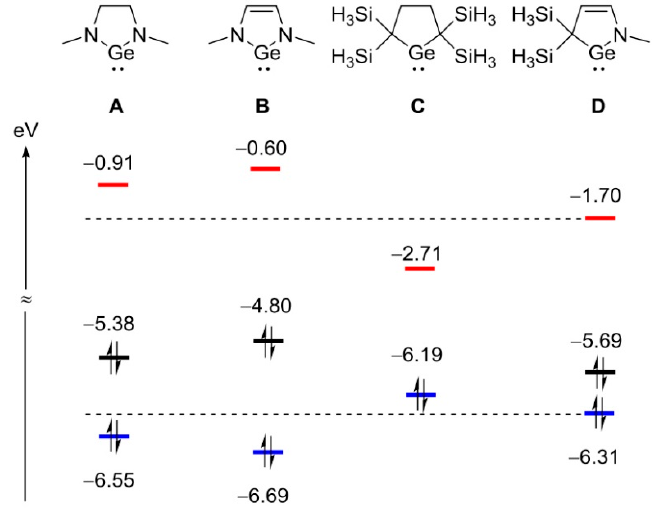
Figure 2. Energy (eV) of frontier orbitals of N -heterocyclic germylenes A , B , cyclic dialkylgermylene C and (alkyl)(amino)germylene D , calculated at the B3LYP/6-31G(d,p) level of theory.